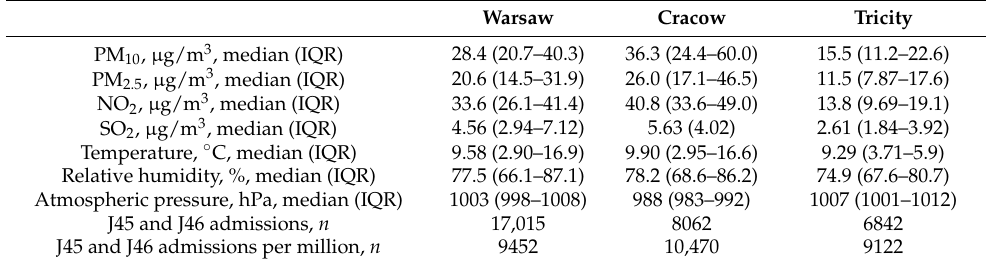
Table 1. Average daily concentrations of air pollutants, average daily values of meteorological variables, and total counts of asthma admission by